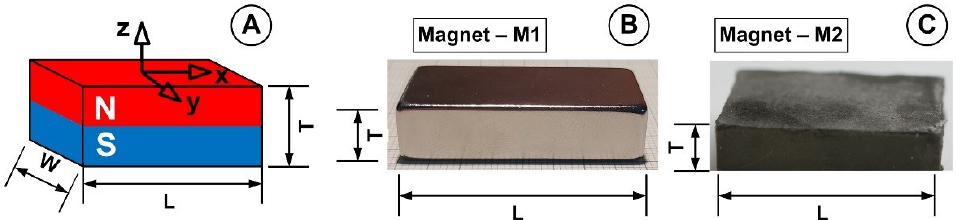
Figure 4. Permanent magnets used in this study. ( A ) Dimensions, axis association, and polarization direction. ( B ) Magnet M1—Neodymium-type magnet with grade N52. ( C ) Magnet M2—ferrite-type magnet with grade Y35.